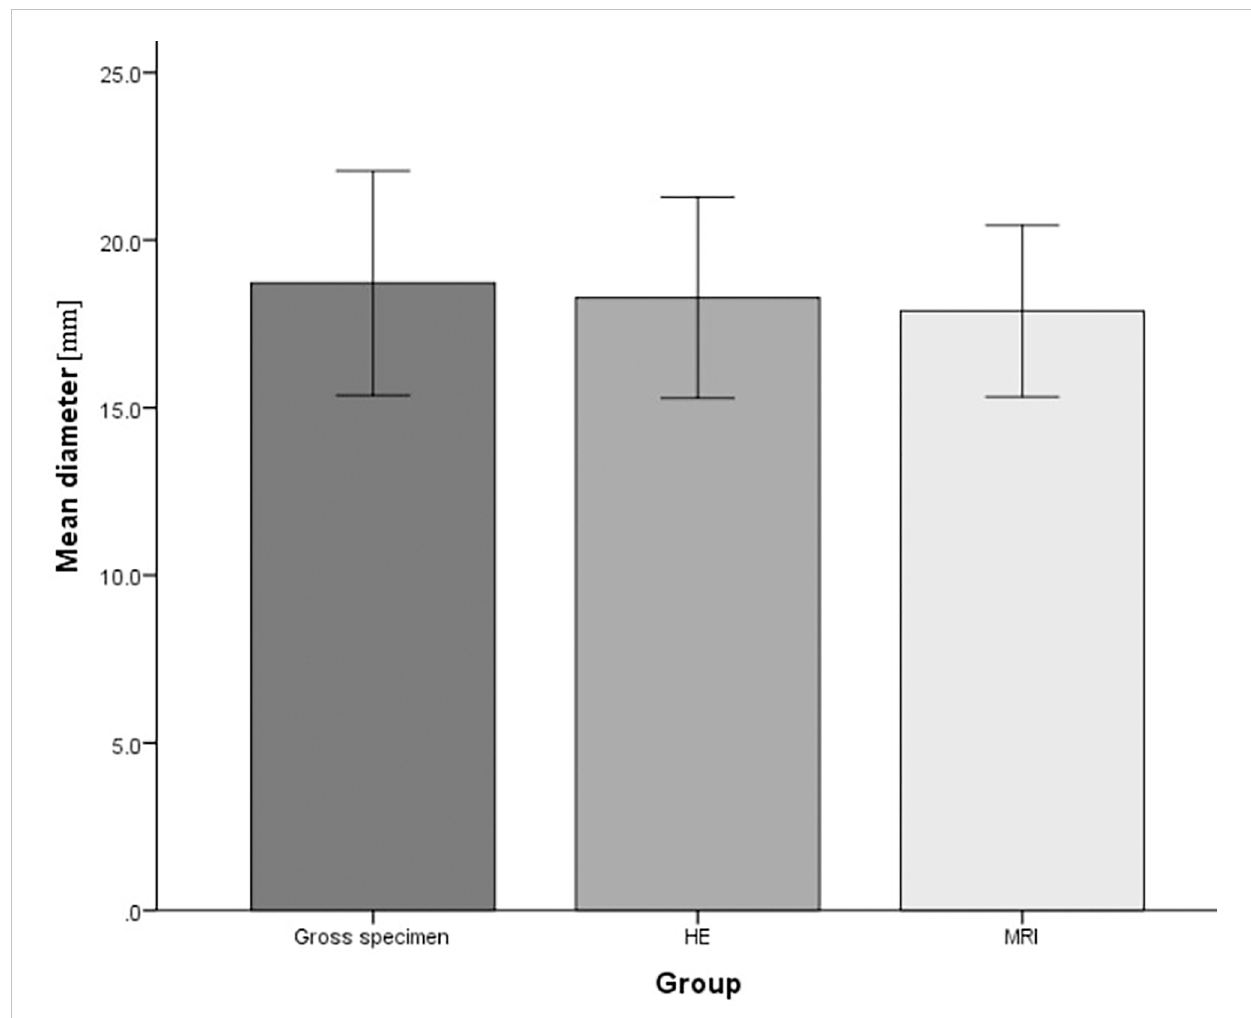
FIGURE 5 The diameter of radiofrequency ablation (RFA) in gross specimens, Hematoxylin and eosin (HE), and magnetic resonance (MR) imaging. The average diameter was 18.72 ± 2.69cm in gross specimens, 18.28 ± 2.41in HE, 17.88 ± 2.06cm in MR